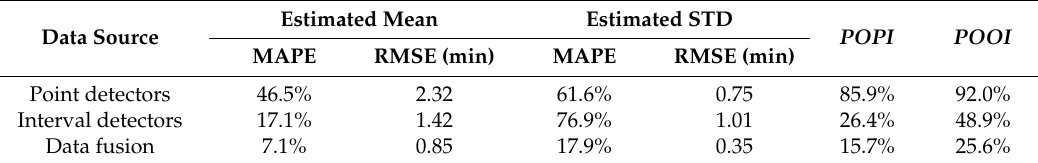
Table 3. The accuracy of data fusion results and single data source results.